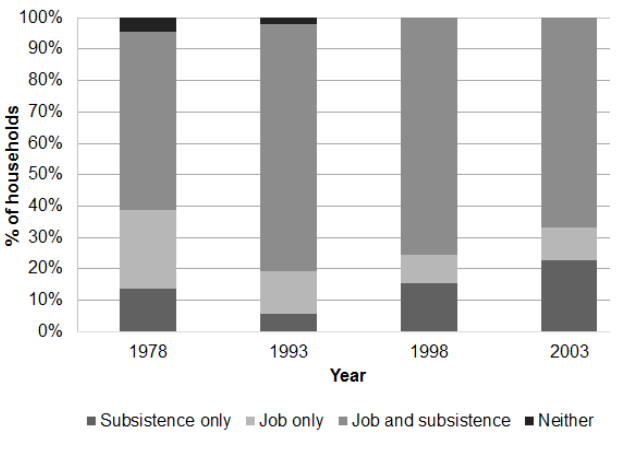
Fig. 4. Household mix of jobs and subsistence activities for Anaktuvuk Pass. Source: North Slope Borough census 1978,